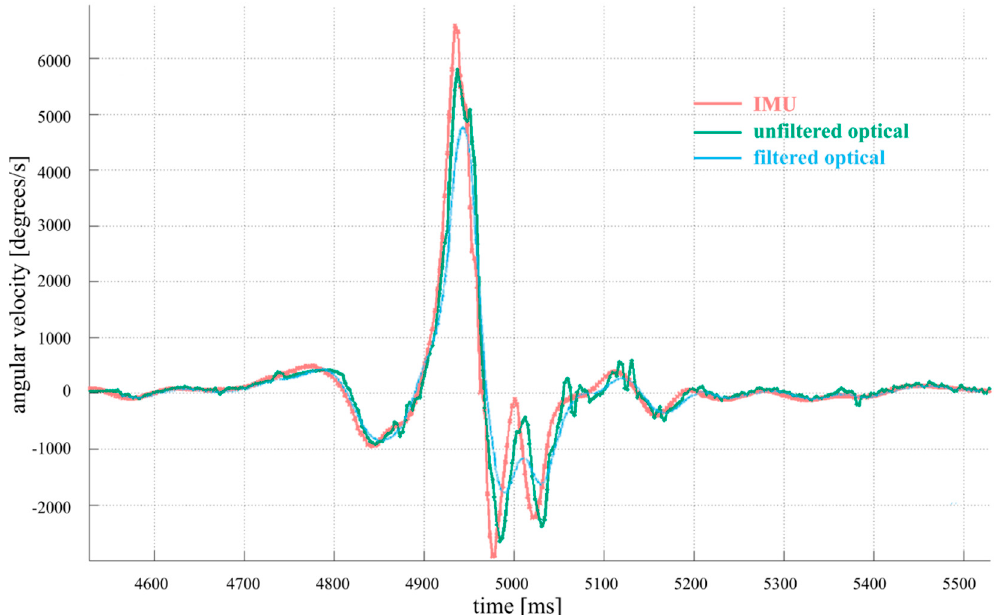
Figure 4. Z h axis angular velocity of the hand for a typical fastball pitch: IMU, filtered and unfiltered optical data. The loss of information on filtered optical data is noticeable in the amplitude and dynamics.